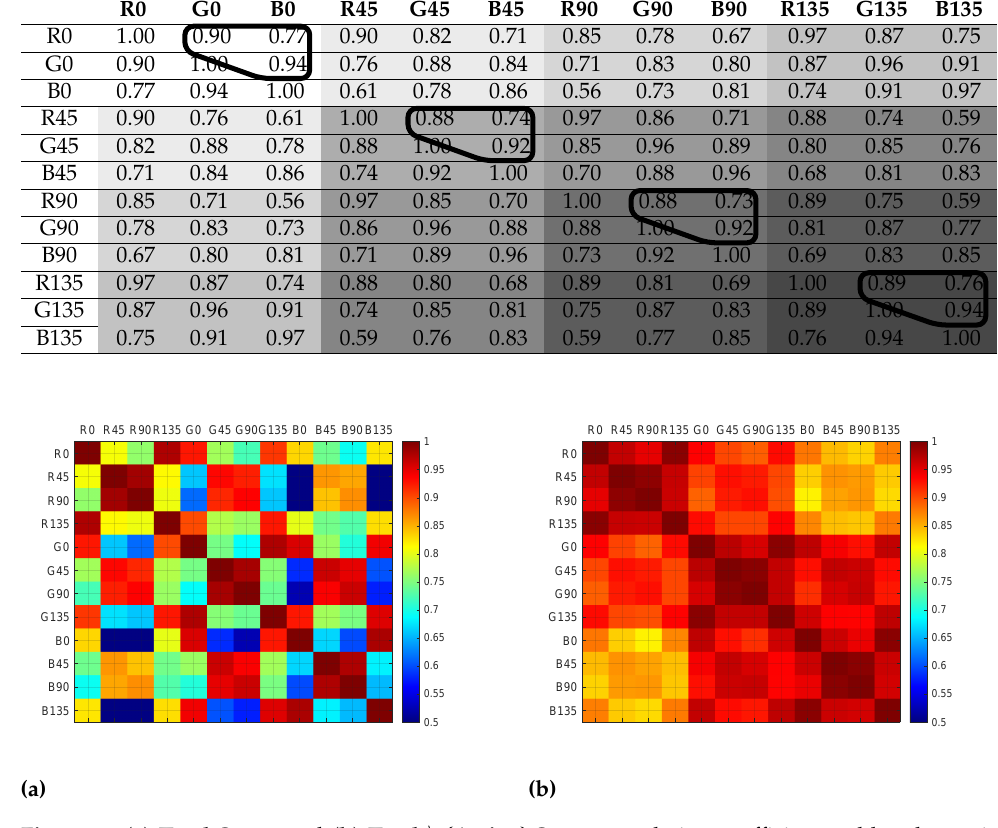
Figure 5. ( a ) Total Scene and ( b ) Total \ {Active} Scene correlation coefficients tables shown in false